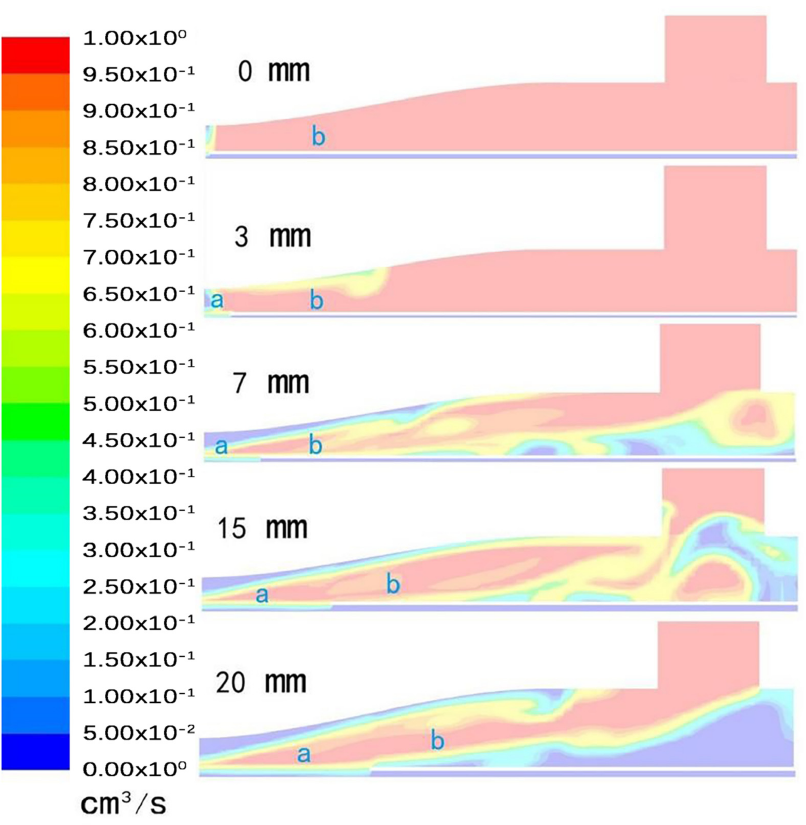
Figure 7. Distribution of volume fraction of gas-liquid under different tube-nozzle distances. Mixed flow zone a; mixed flow zone b.